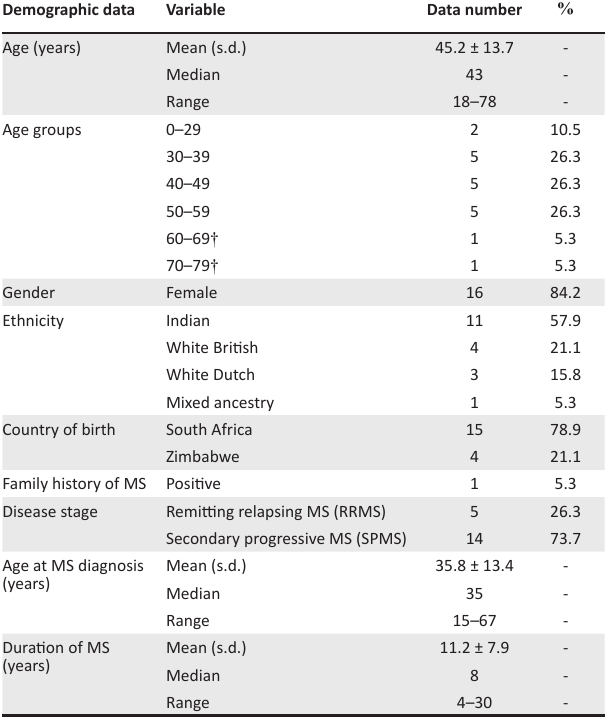
TABLE 1: Demographic data of patients with multiple sclerosis. Demographic data